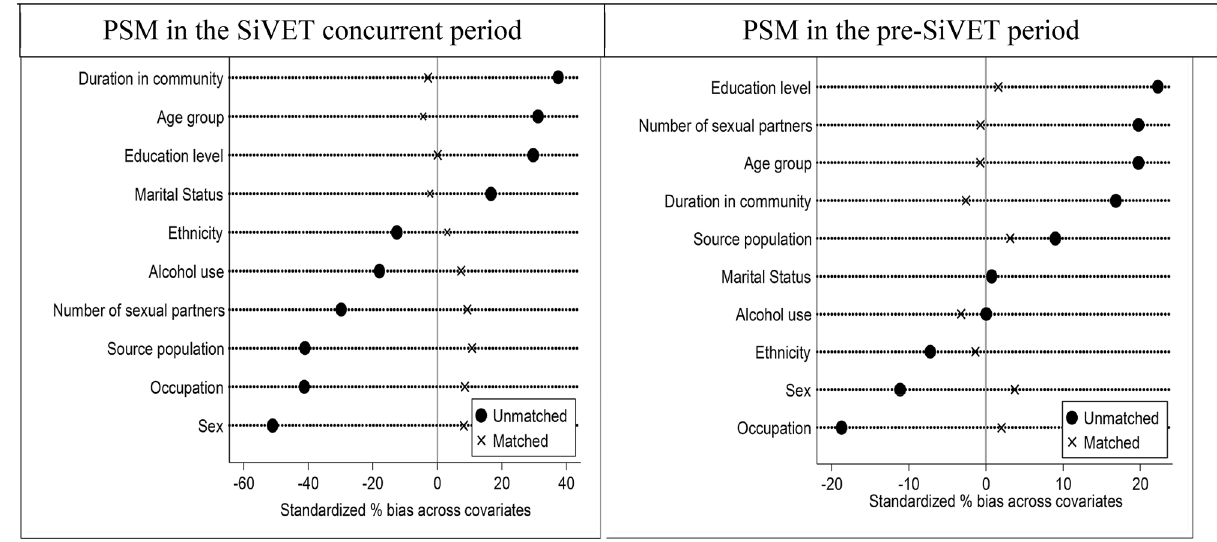
Figure 3. Standardized differences across covariates: pre-matching and post-matching.